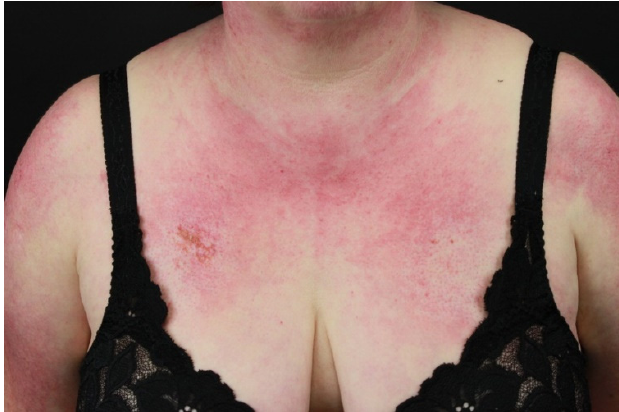
Figure 6. Paraneoplastic dermatomyositis (V-sign). Erythematous maculopapular rash of the V area of upper chest.